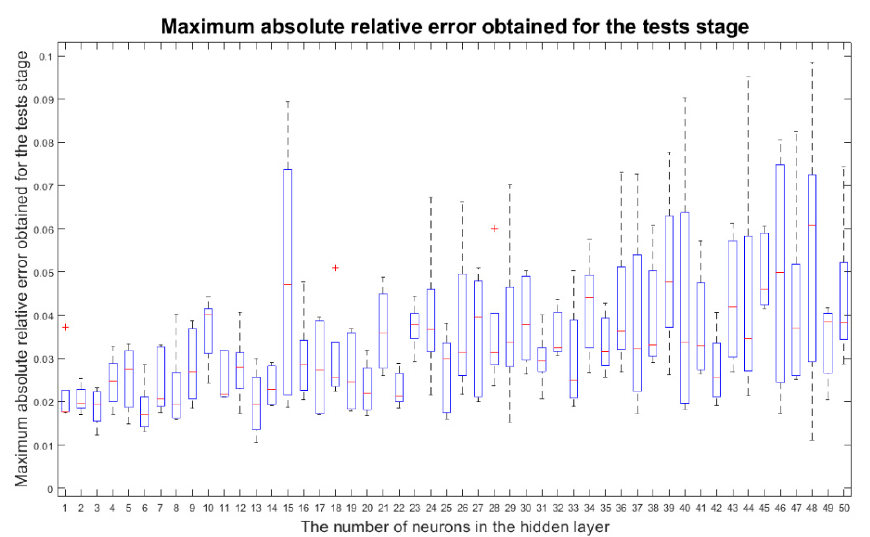
Figure 8. Maximum absolute relative error obtained for the neural network structure with a certain number of neurons in a hidden layer—results for the tests on stage.